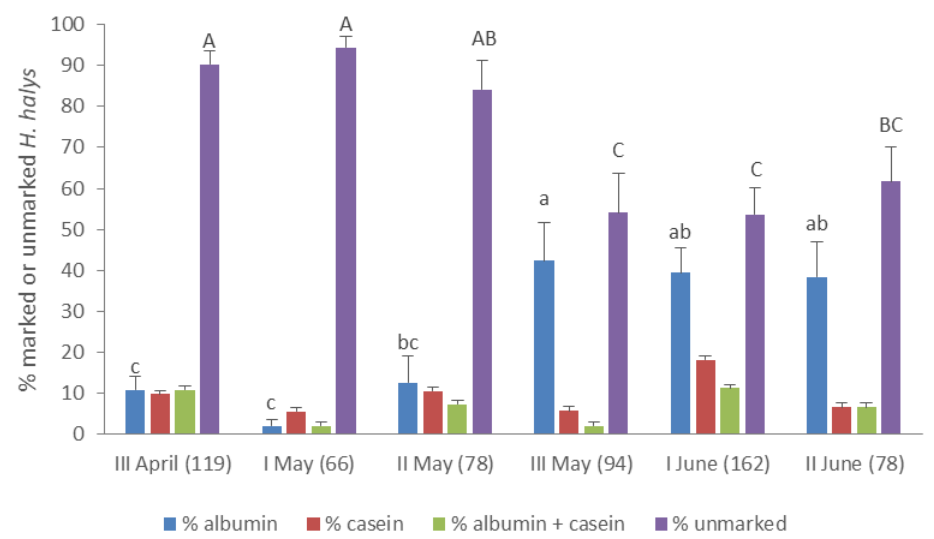
Figure 4. Mean percentages ( ± SE) of marked and unmarked Halyomorpha halys adults captured in the four study areas from late April to mid-June. Lower case and upper case letters indicate significant differences between 10-day periods for albumin positive and unmarked specimens, respectively (Tukey’s test following one-way ANOVA, p < 0.05). On the x-axis, for each 10-day periods, the total number of tested specimens is given in brackets.